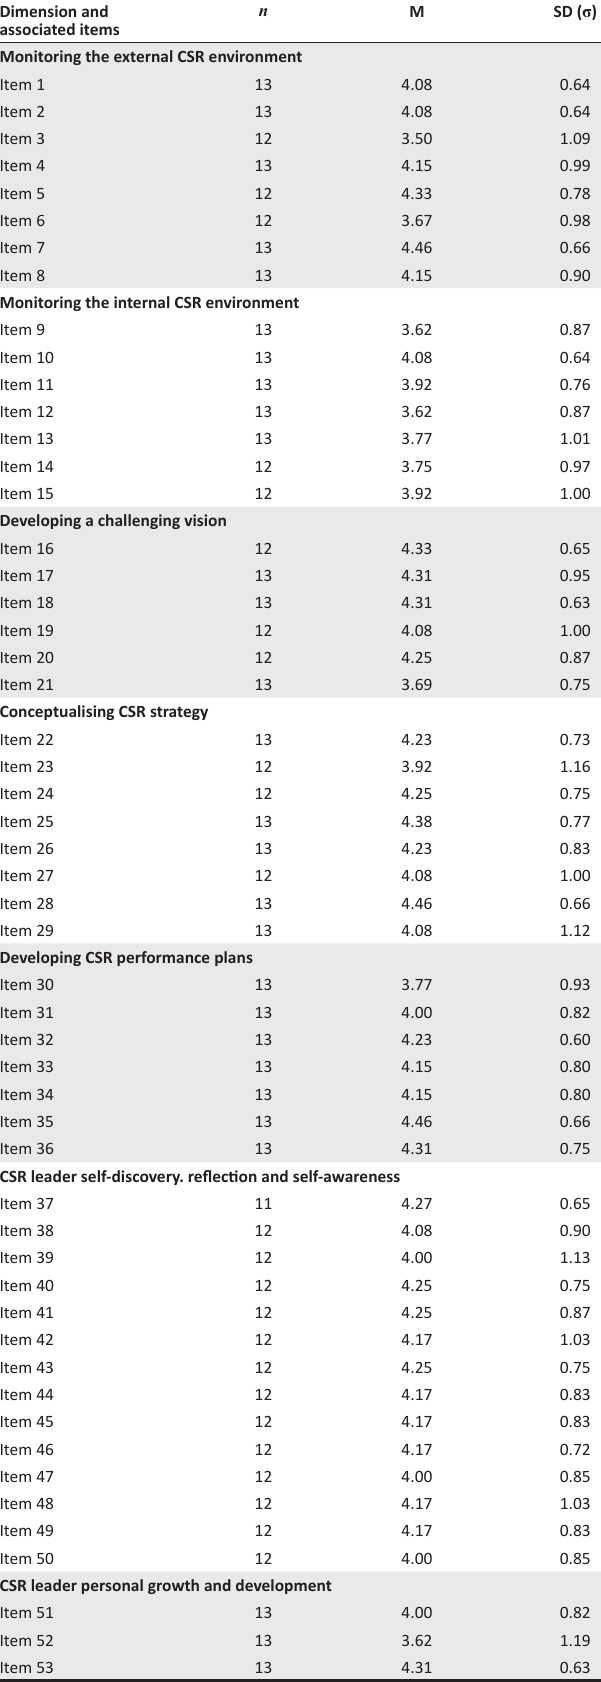
TABLE 3: Descriptive statistics results for item ratings by expert judges. Dimension and associated